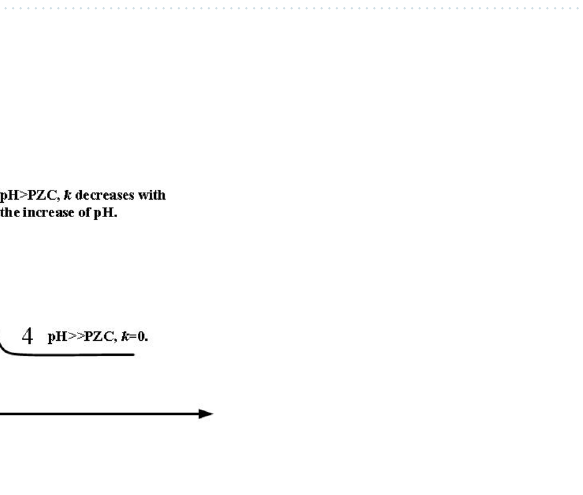
Figure 1. The change of aggregation rate, k , with pH for different initial particle concentration and pH change rate.